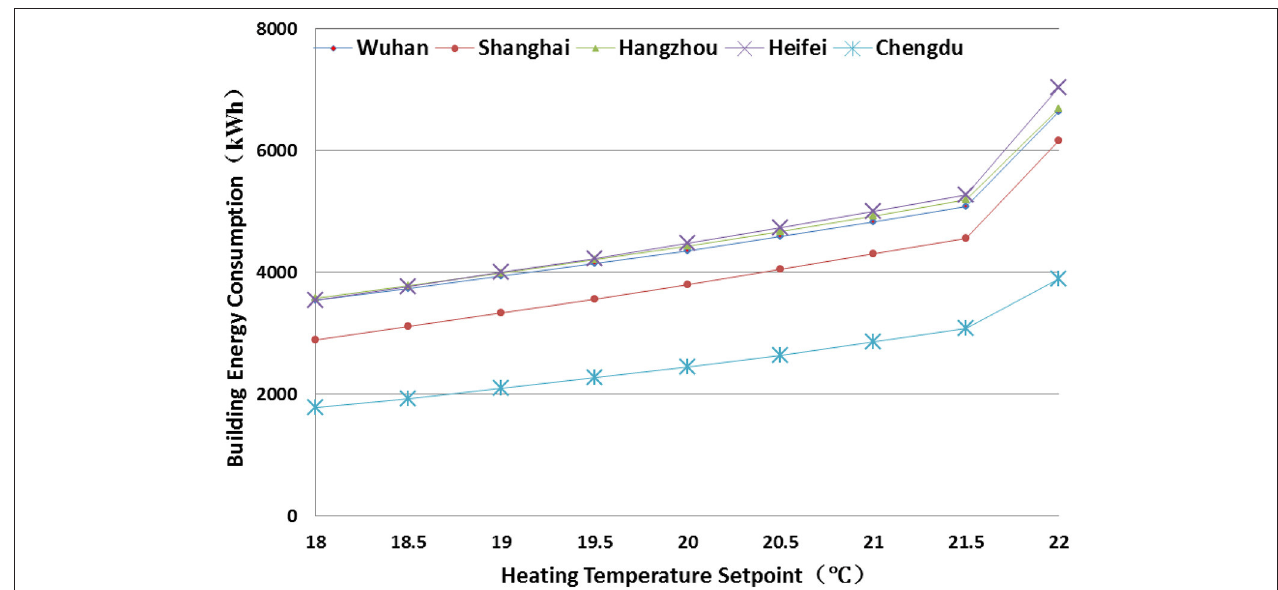
FIGURE 9 | Sensitivity analysis of heating temperature setpoint on annual energy consumption.